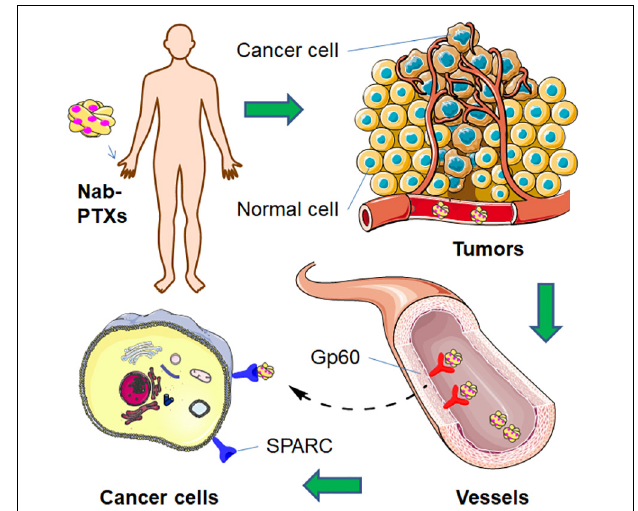
FIGURE 6 | The endocytosis mechanism of